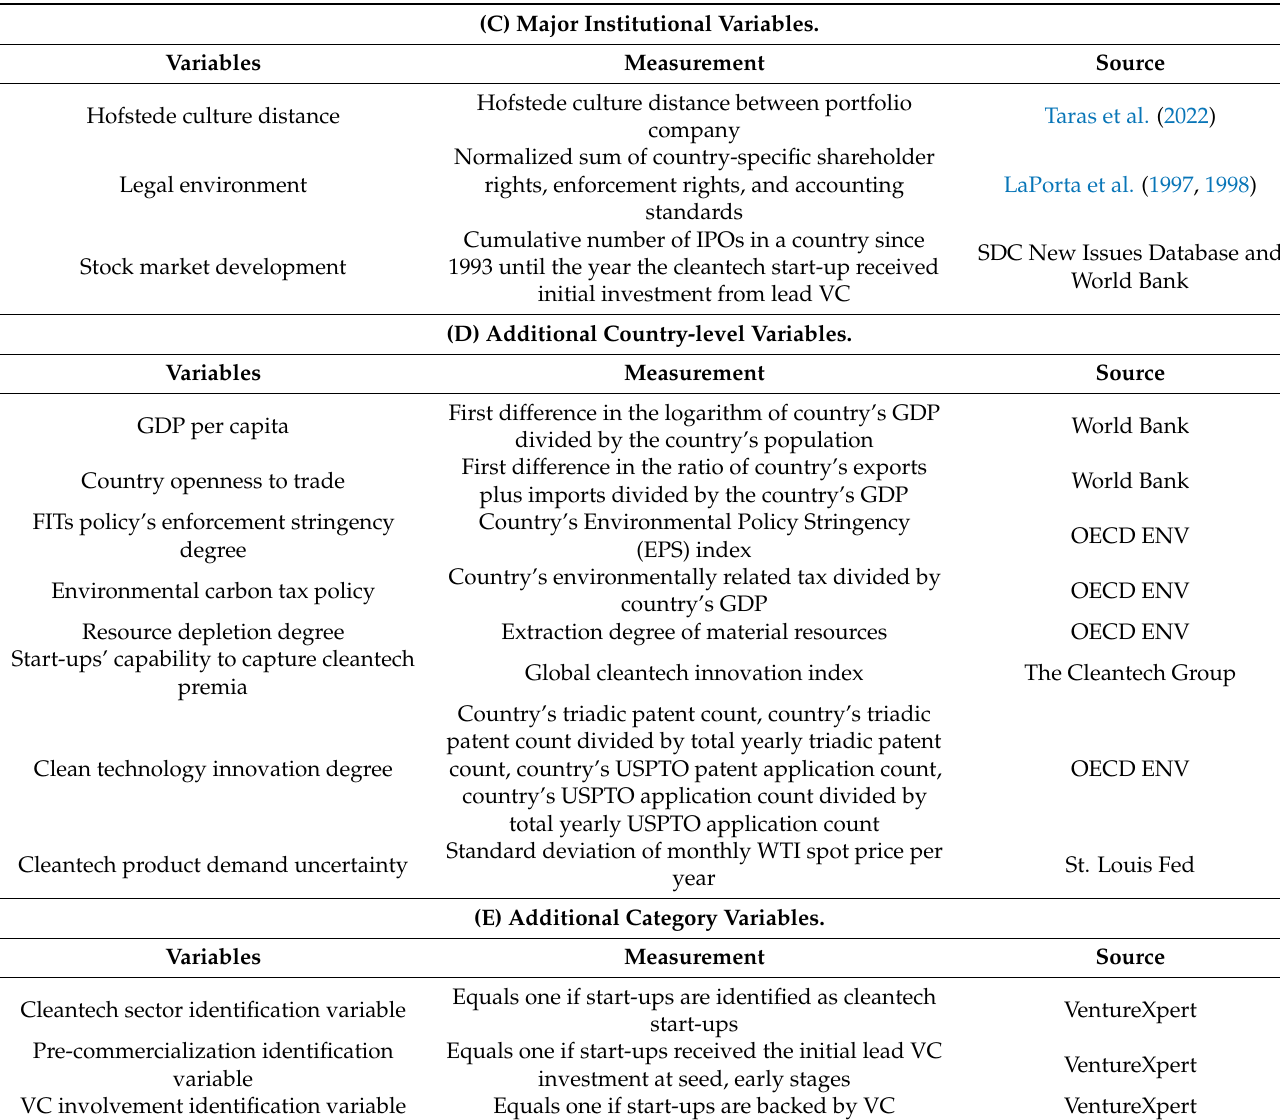
Table 2. Cont. (C) Major Institutional